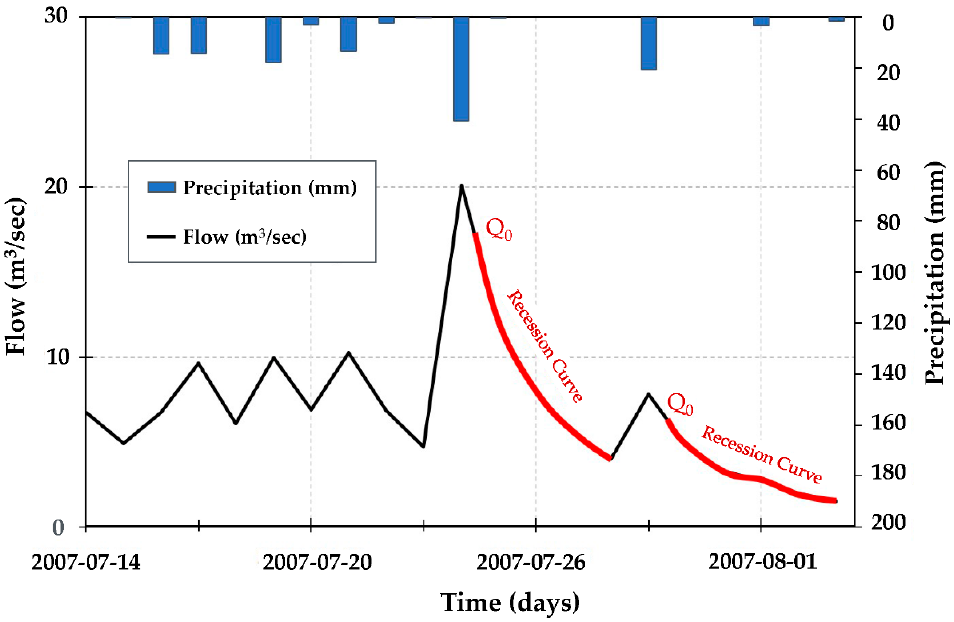
Figure 2. Definition of recession curves (Kullman [39], enhanced).